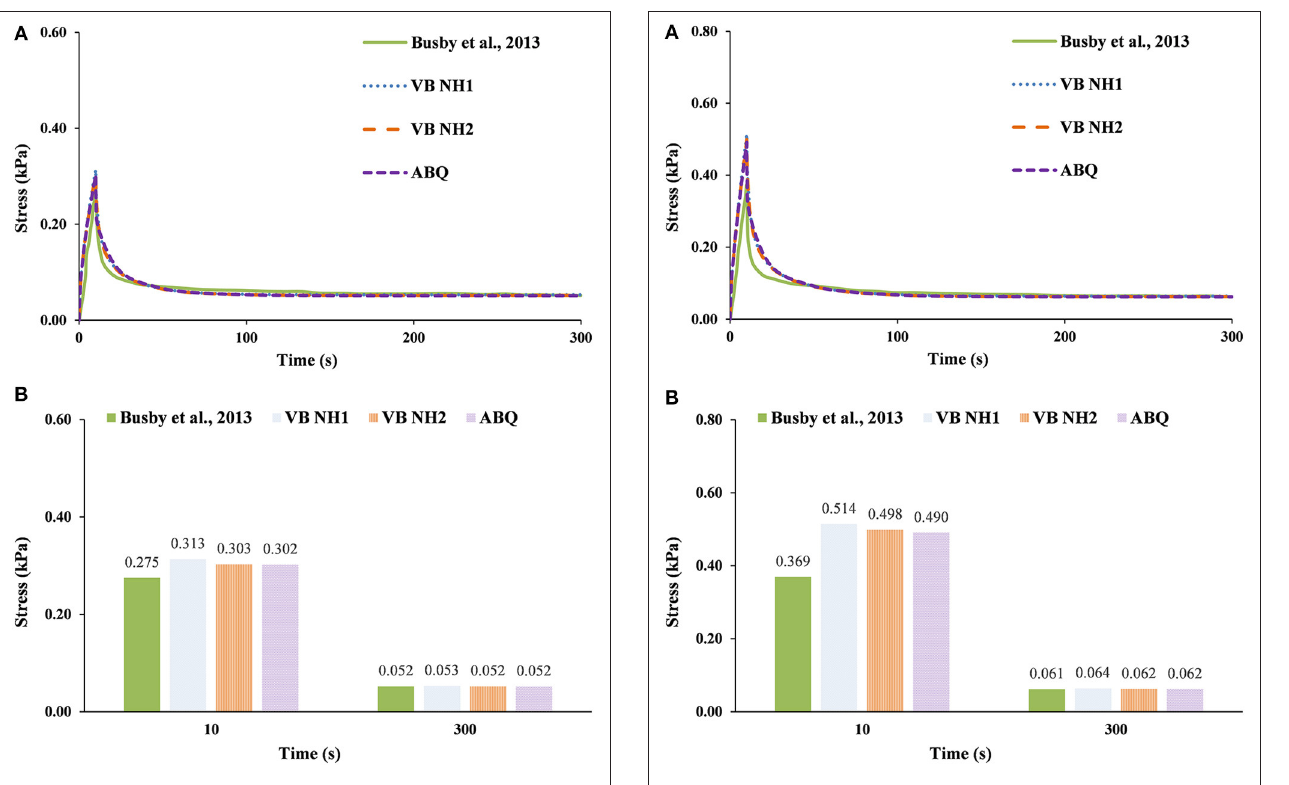
FIGURE 5 | 0.30% collagen hydrogel during 300s stress relaxation test. The experimental data of Busby et al. (2013) is here compared with numerical calculations using V-Biomech, and Abaqus: (A) Stress relaxation over time; (B) Peak and end effective stress values.